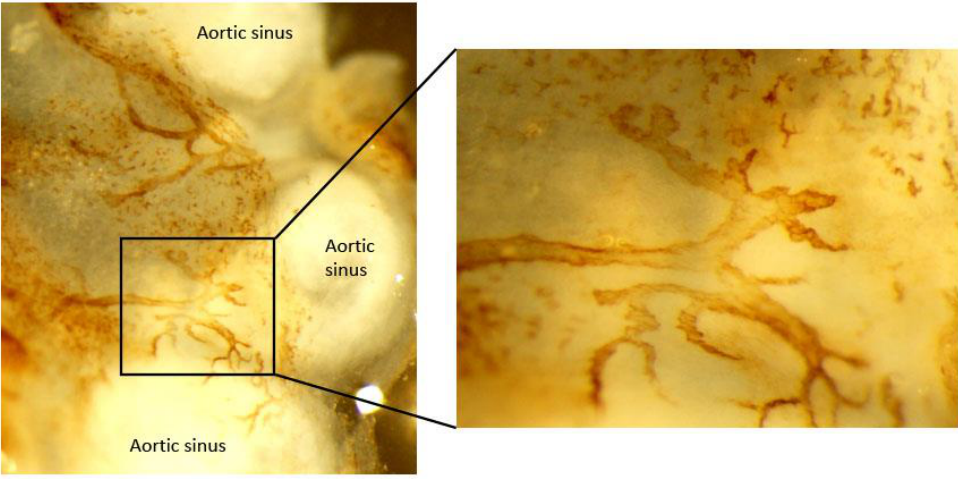
Figure 2. Image of initial lymphatic vessel in adventitia of atherosclerotic mouse aortic sinus. Aorta whole mount was stained for LYVE-1 to identify initial lymphatic vessels in the adventitia of Apoe −/− mice.